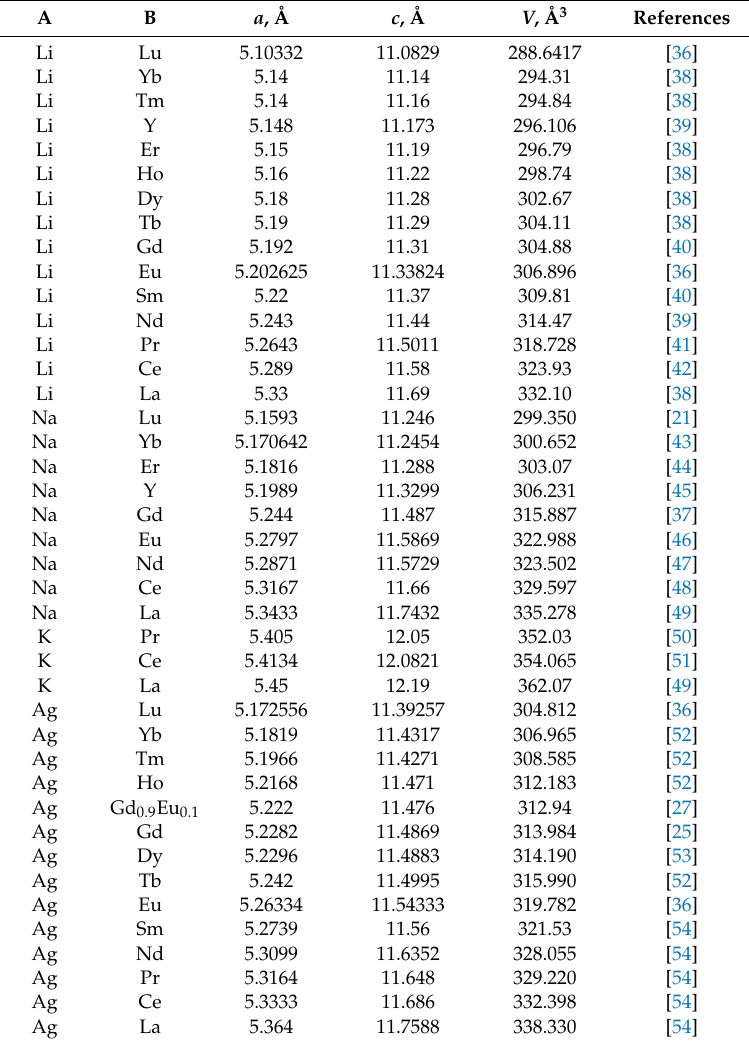
Table 4. Cell parameters of AB(MoO 4 ) 2 compounds with I 4 1 / a space